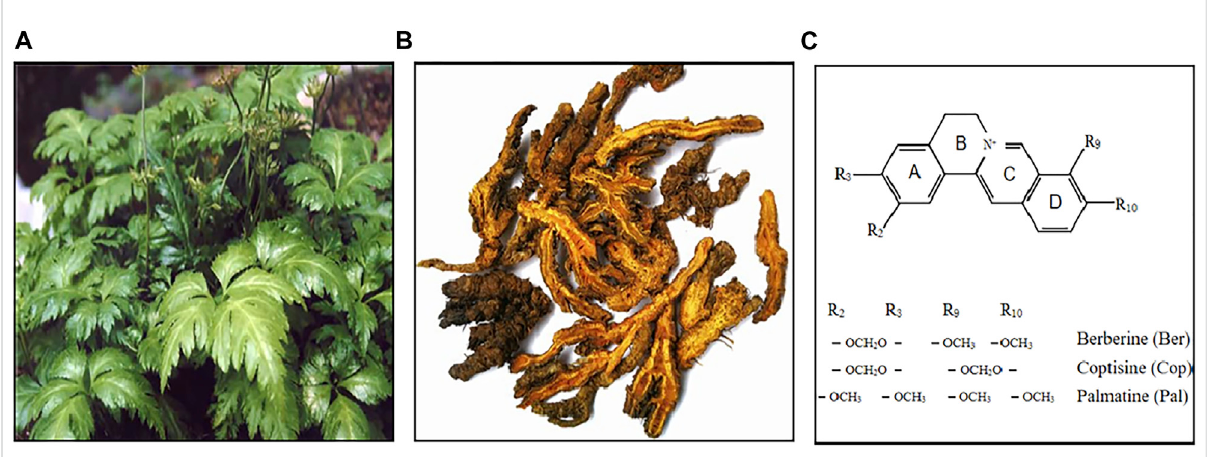
FIGURE 3 Coptis Chinensis Franch. Whole plant (A) , dry root (B) , chemical structure of berberine, coptisine, and palmatine (C)